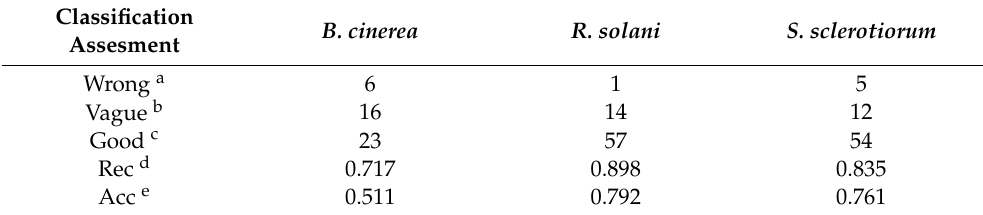
Table 3. Reliability in distinguishing three species of fungi based on RGB